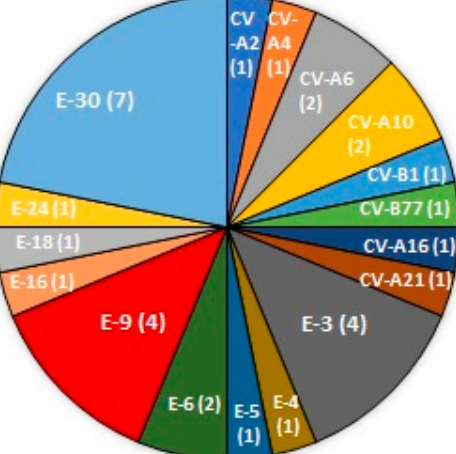
Figure 2. Found serotypes in 32 patients with EV encephalitis. The number of samples is denoted by the number in the pie chart.